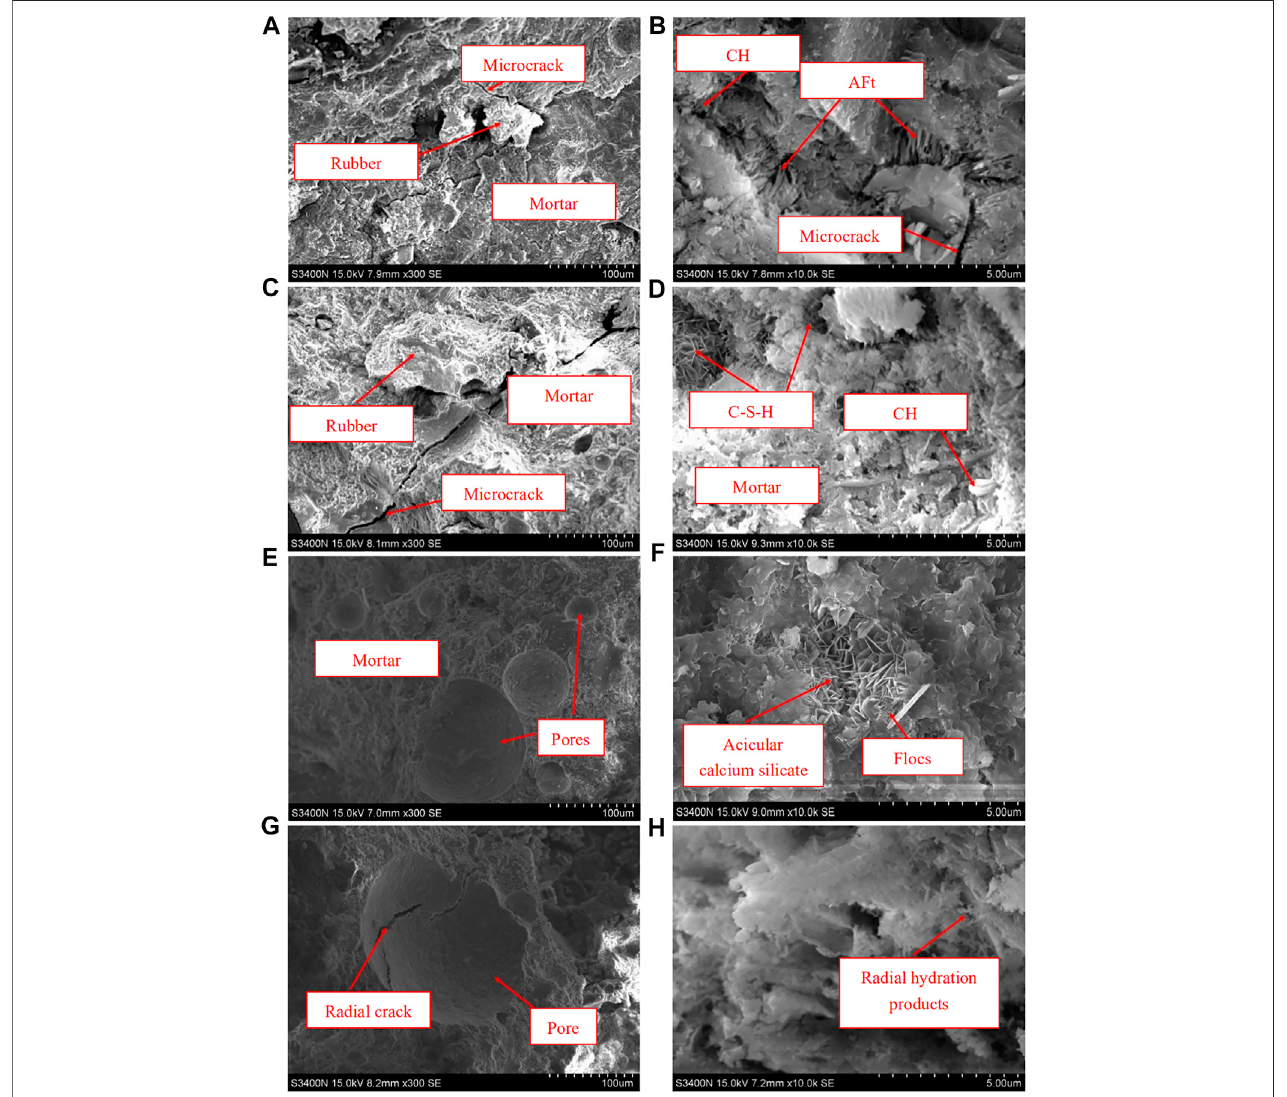
FIGURE 15 | Microstructure of RRAC: (A) and (B) 25 ° C; (C) and (D) 200 ° C; (E) and (F) 400 ° C; (G) and (H) 600 ° C.